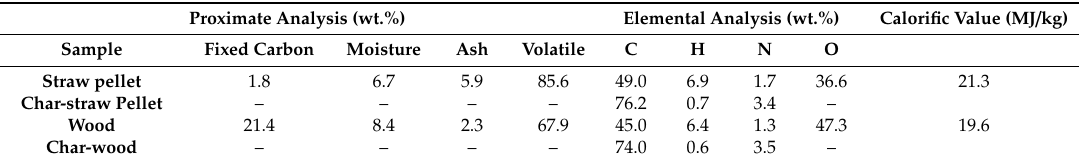
Table 1. Composition and properties of the raw waste materials used in the experiments and the chars obtained by